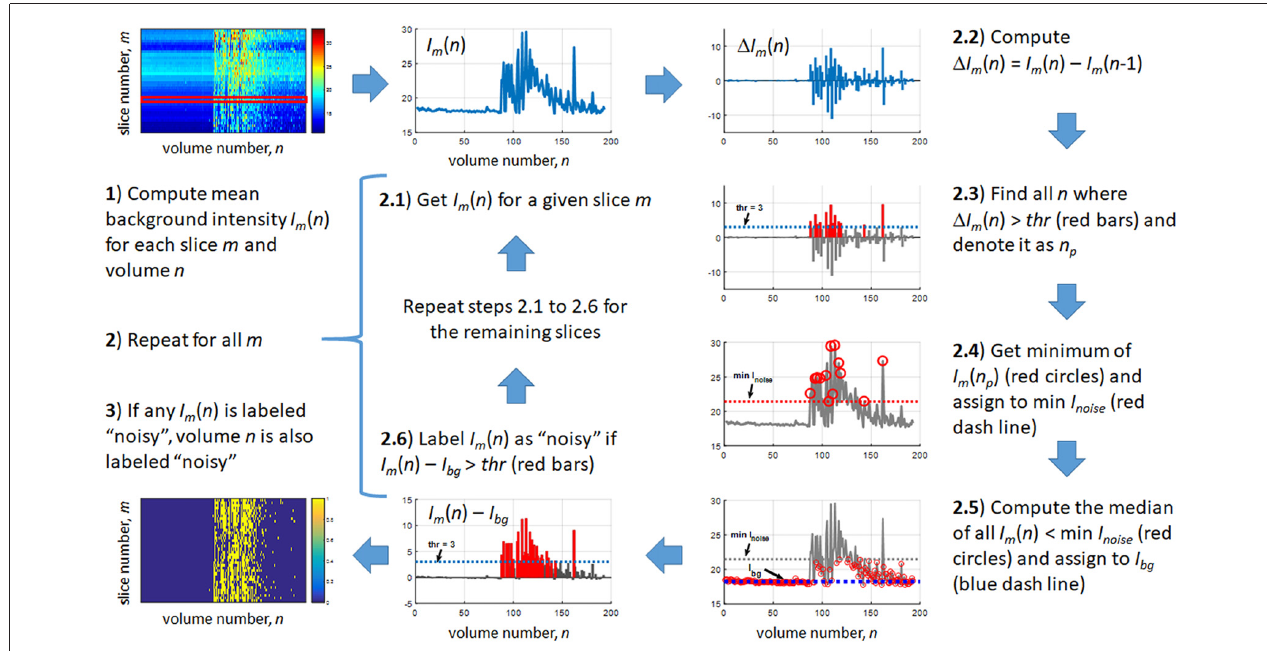
FIGURE 2 | Outline of the proposed method for the automatic detection of gradient coil